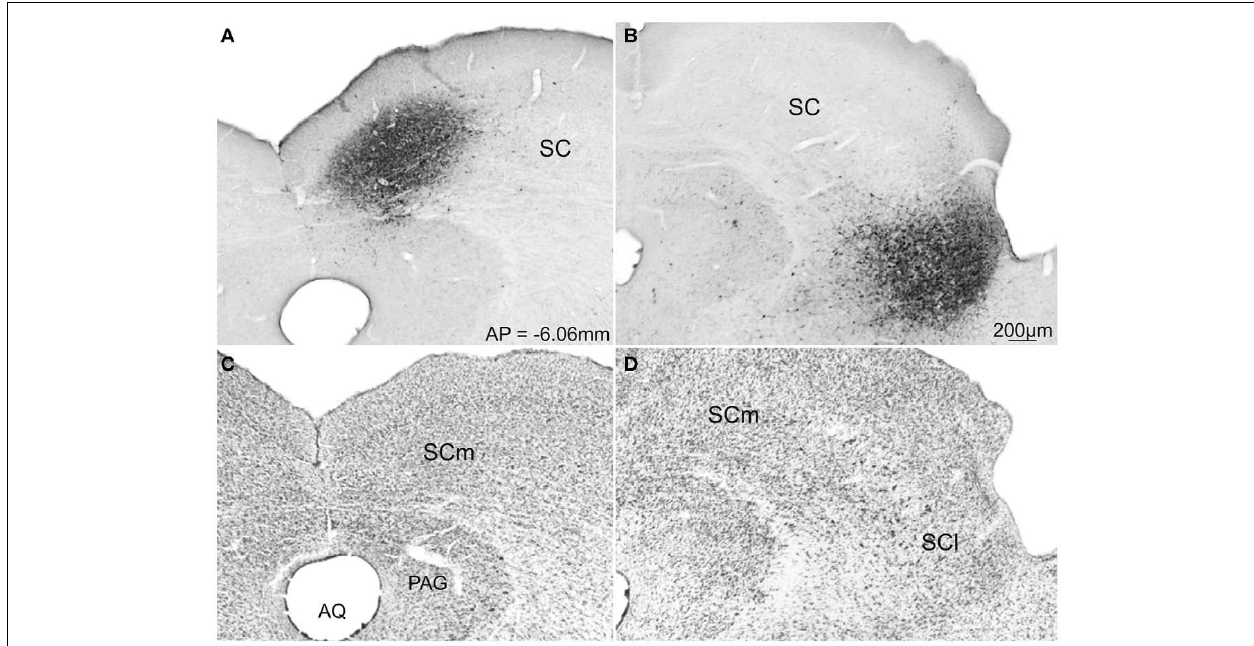
FIGURE 4 | Photomicrographs of transverse sections of the rat brain showing representative cases with FG injection into the SCm (A) and SCl (B). Respective adjacent sections show the SC cytoarchitecture stained with Nissl stain (C,D) . Abbreviations: see list.